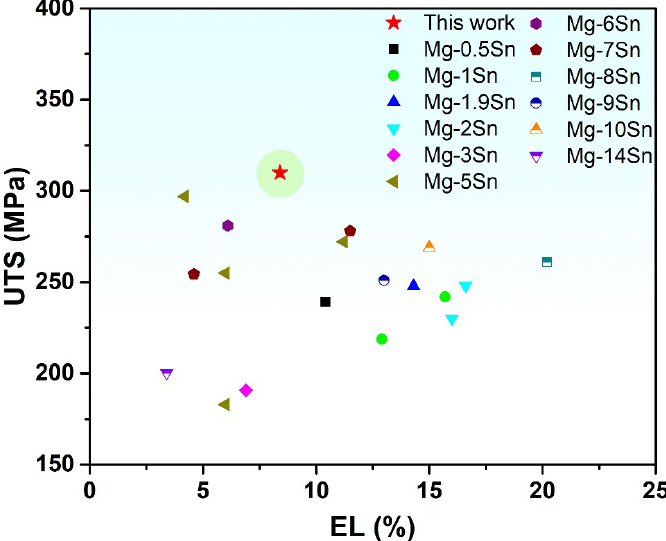
Figure 7. Mechanical performance comparison between the R70 alloy developed in this work and recently developed hot rolled Mg-Sn alloys [14,15,17–19,42–48]. Table 1. YS, UTS, and EL of as-cast and hot rolled Mg-5Sn alloys.